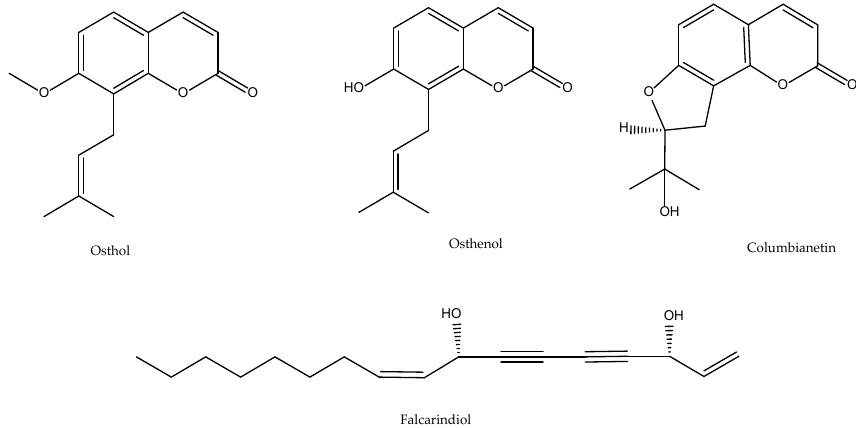
Figure 3. Bioactive anti-inflammatory (eicosanoid inhibition) and antioxidant principles from A. pu- bescens. A.